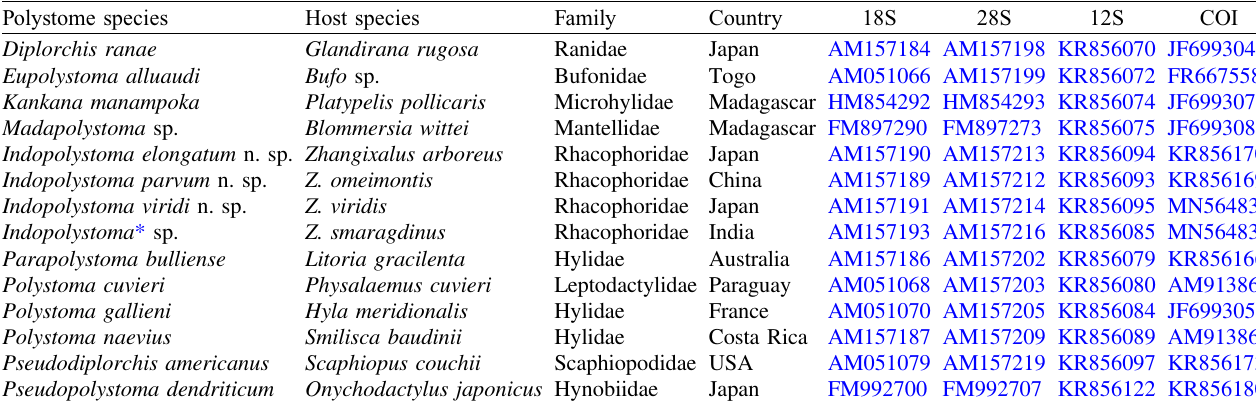
Table 1. Species of polystomes investigated with their 18S, 28S, 12S and COI GenBank Accession numbers. Indopolystoma spp. were considered earlier as Polystoma spp. in Verneau et al . [51], Badets et al . [2] and Héritier et al .